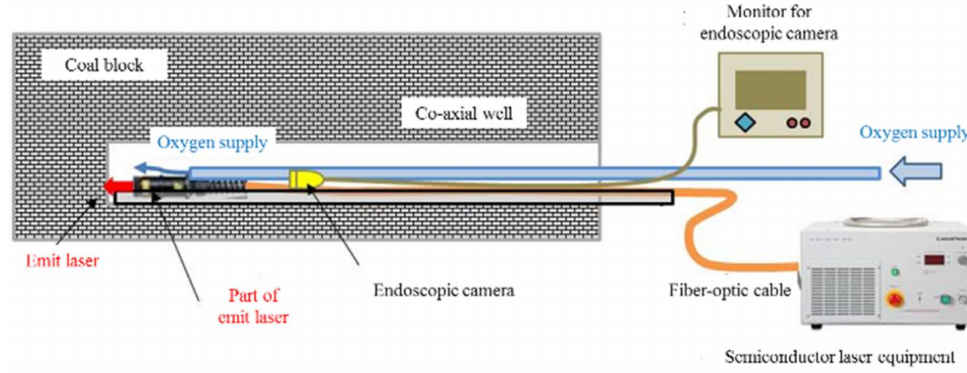
Figure 5. Laser ignition system.